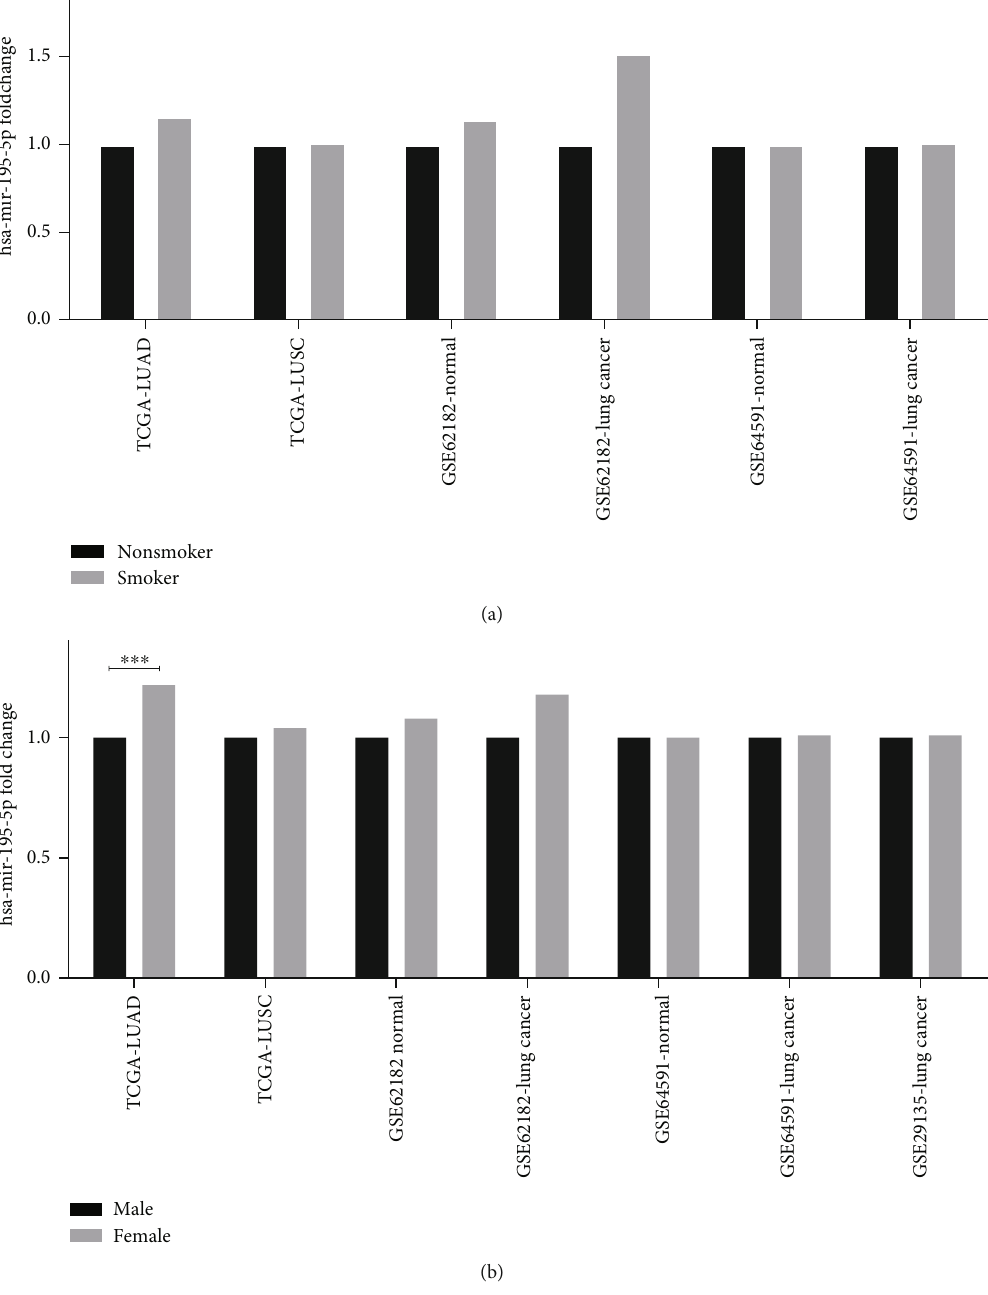
Figure 2: Expression of hsa-miR-195-5p in di ff erent sexes and smoking statuses among lung cancer and COPD patients. In most datasets, sex and smoking status of patients do not a ff ect the expression of hsa-miR-195-5p . The expression of hsa-miR-195-5p is higher in females than in